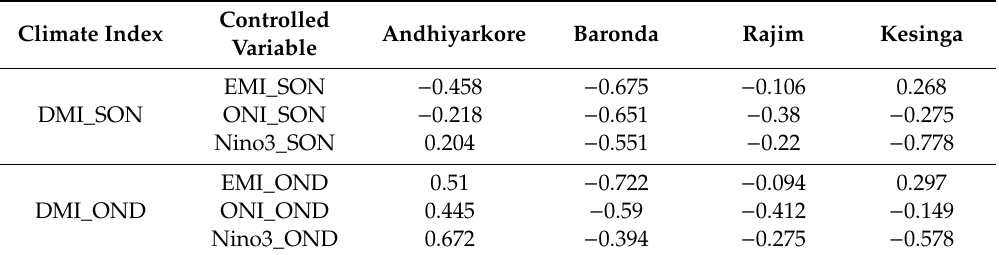
Table 7. Partial correlation of streamflow anomaly of the JJA season with Dipole Mode Index (DMI) of the SON and the October–December (OND) season.